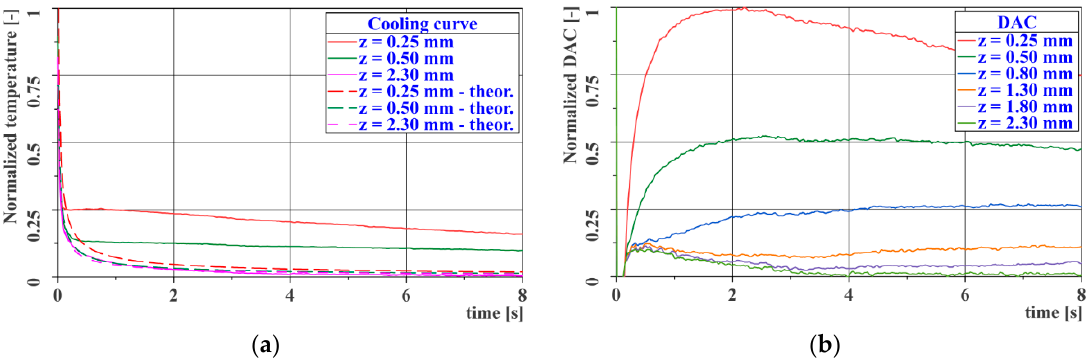
Figure 13. Cooling curves for the reference gauge: ( a ) linear time axis; ( b ) Differential Absolute Contrast (DAC) curves.